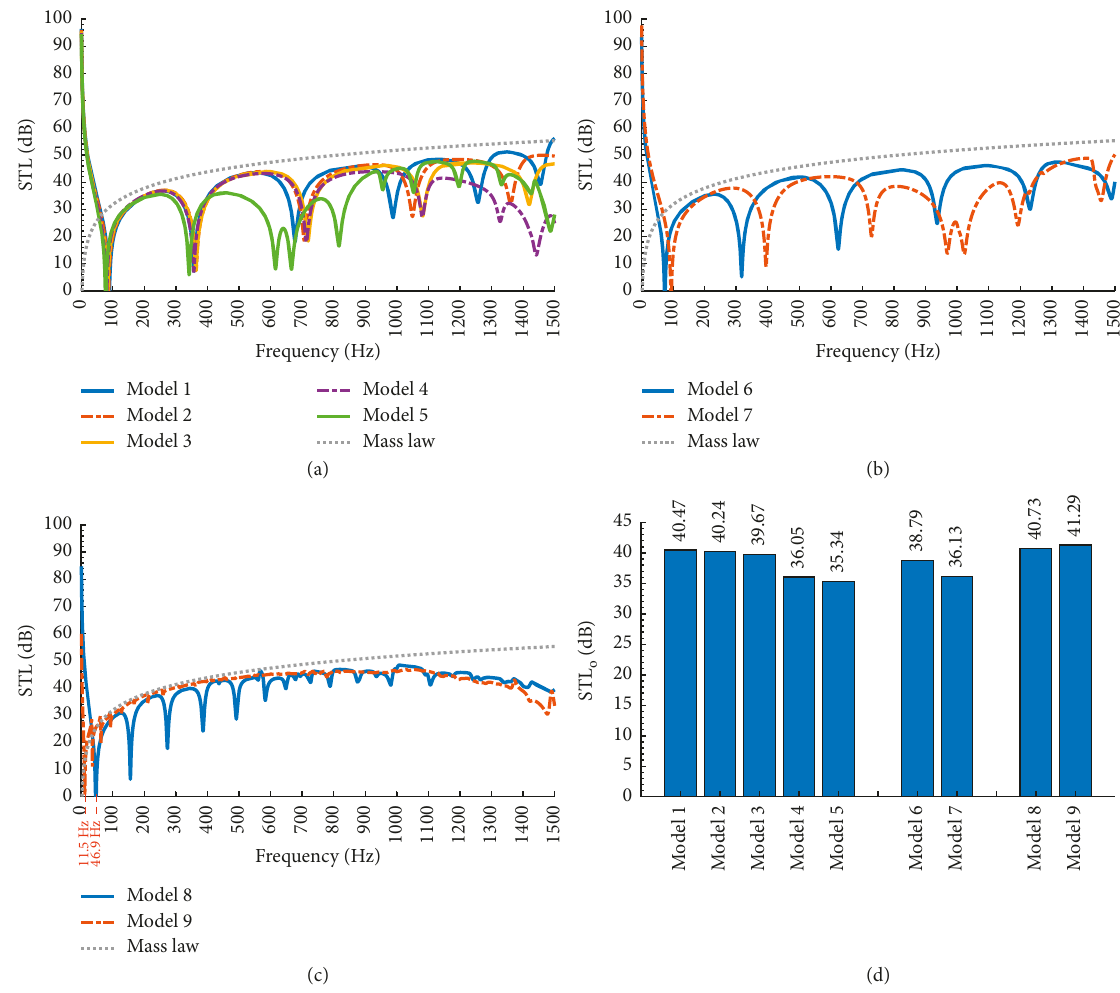
Figure 13: STLs of the representative sandwich models: (a) models 1 to 5; (b) models 6 and 7; (c) models 8 and 9. (d) The overall average STLs for the constant-weight sandwich models from 1 to